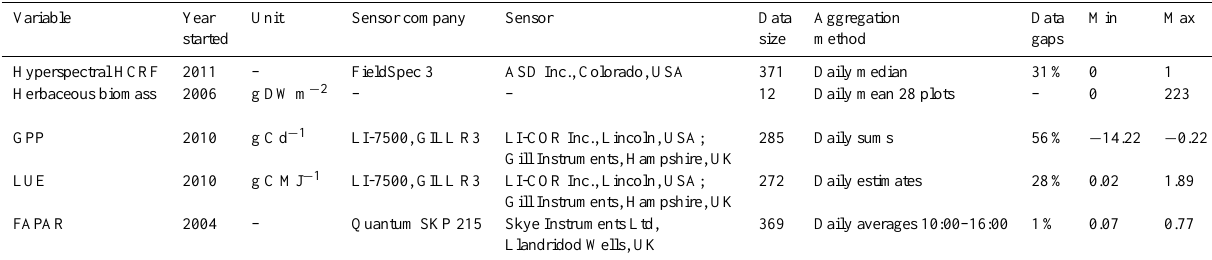
Table 1. Information about the instrumental setup for the measured environmental variables. HCRF is hemispherical conical reflectance factor, GPP is gross primary productivity, LUE is light use efficiency, and FAPAR is fraction of photosynthetically active radiation absorbed by the vegetation. Min and Max are minimum and maximum values measured, respectively, DW is dry weight, C is carbon, and MJ is megajoules. The year started is the first year with measurements. Time is in UTC. For more information about the instrumental setup, see Tagesson et al.